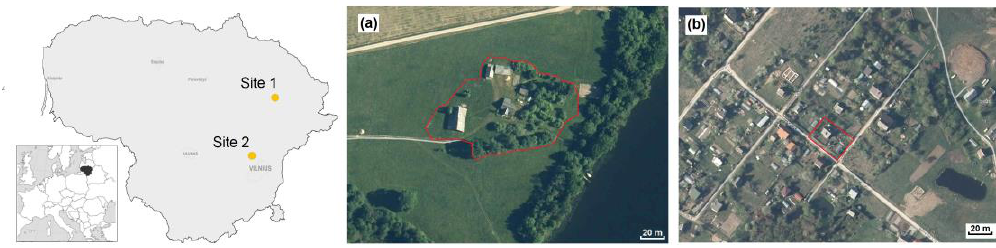
Figure 1. Location of the study sites in Lithuania ( a ): Site 1, homestead near Davainiai forest, Leliūnai, Utena district (55.444 N, 25.464 E), and ( b ): Site 2, kitchen garden in Brinkiškės, Vilnius district (54.822 N, 25.104 E).